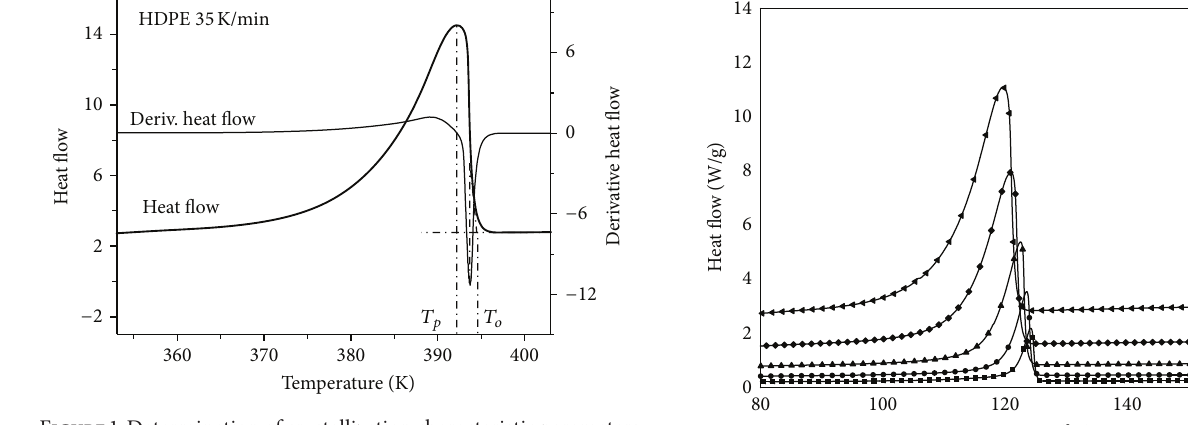
Figure 1: Determination of crystallization characteristic parameters of HDPE and its composites by using neat HDPE as an example (cooling rate = 35 K/min).